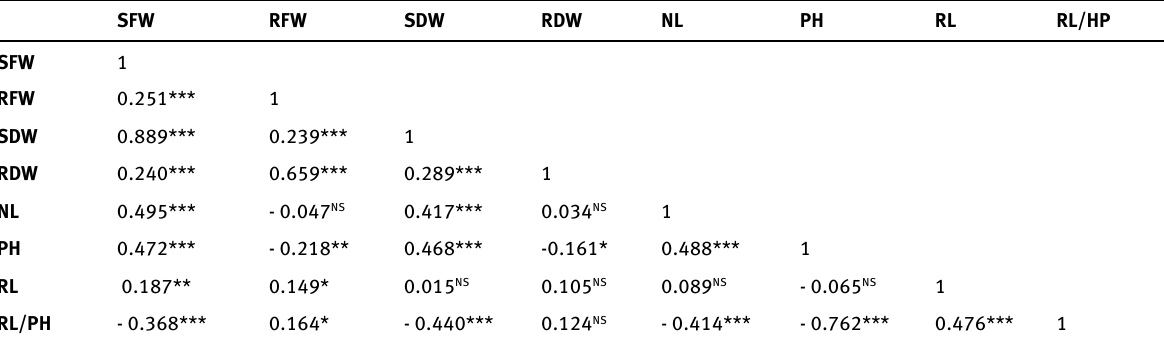
Table 6: Pearson correlation coefficients between growth attributes in common bean genotypes at 6 weeks SFW RFW SDW RDW